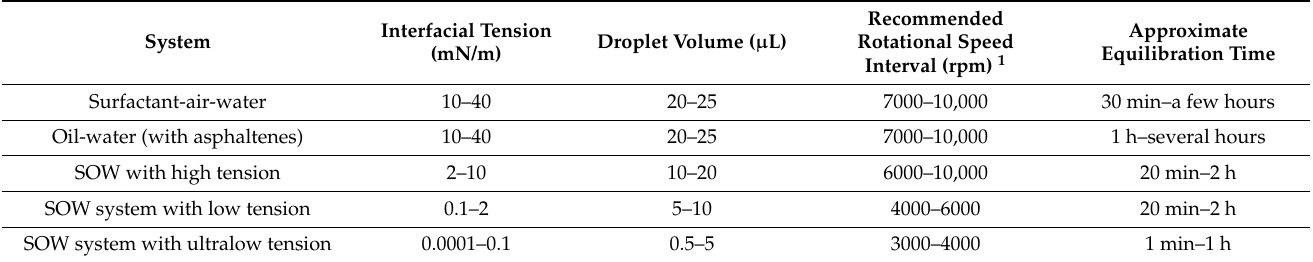
Table 1. Typical values of interfacial (or surface) tension, droplet volume, recommended rotational speed, and equilibration time for operation with the oscillatory spinning drop